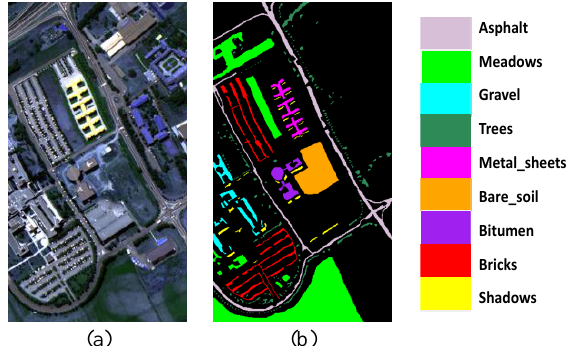
Figure 3 (a) The Pavia University image. (b) The ground-truth samples for the Pavia University image.